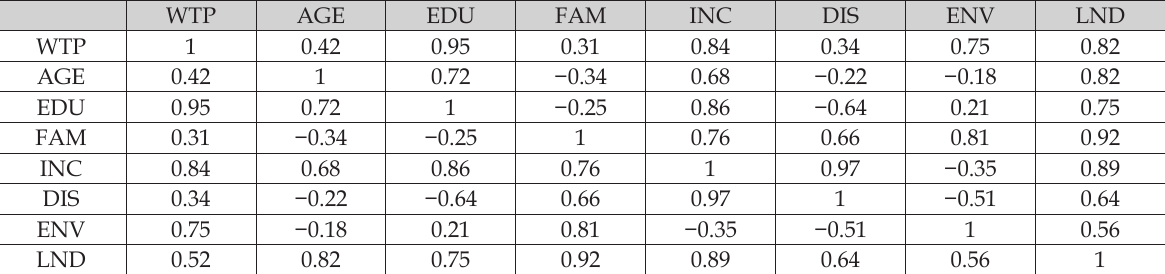
Table 11. Pearson’s correlation among the